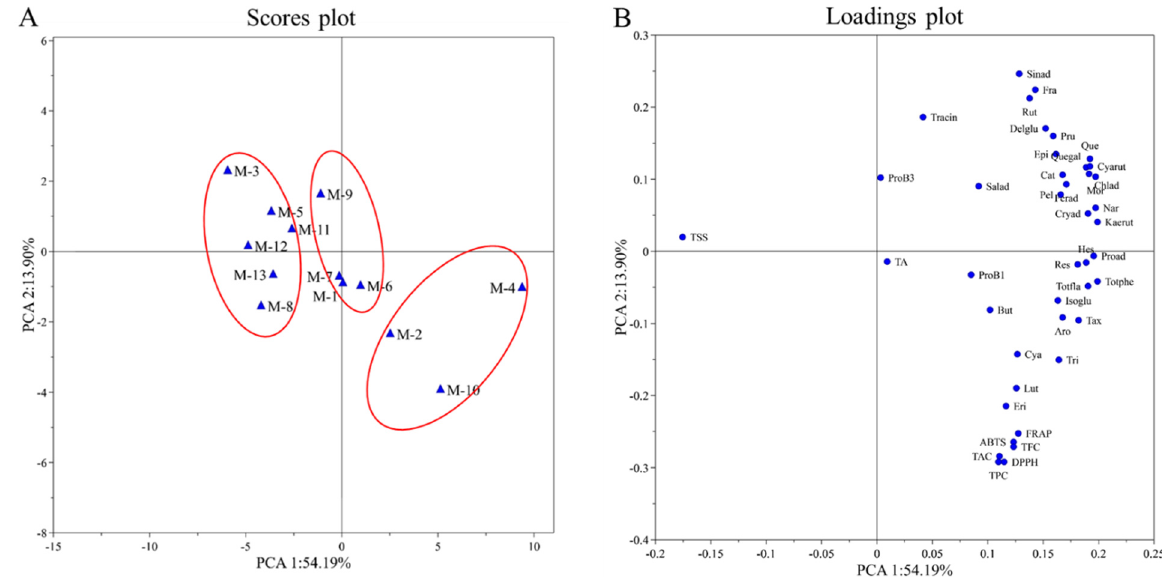
Figure 2. ( A ) PC scores plot of the mulberry samples; ( B ) loadings plot of the mulberry samples. Salad, salicylic acid; TraCin, trans-cinnamic acid; Proad, protocatechuic acid; Chlad, chlorogenic acid; Cryad, cryptochlorogenic acid; Ferad, ferulic acid; Sinad, sinapic acid; Nar, narcissin; Aro, aromadendrin; Tax, taxifolin; Quegal, quercetin-3-galactoside; Isoglu, isorhamnetin-3-O-glucoside; Kaerut, kaempferol-3-O-rutinoside; Rut, rutin; But, butein; Eri, eriodictyol; Pru, prunin; Hes, hesperidin; Tri, trilobatin; Lut, luteolin; Mor, morin; Que, quercetin; Cat, catechin; Epi, epicatechin; Pel, pelargonidin; Delglu, delphinidin-3-glucoside; Cya, cyanidin-3,5-diglucoside; Cyarut, cyanidin-3-O-rutinoside; ProB1, procyanidin B1; ProB3, procyanidin B3; Fra, fraxin; Res, resveratrol.